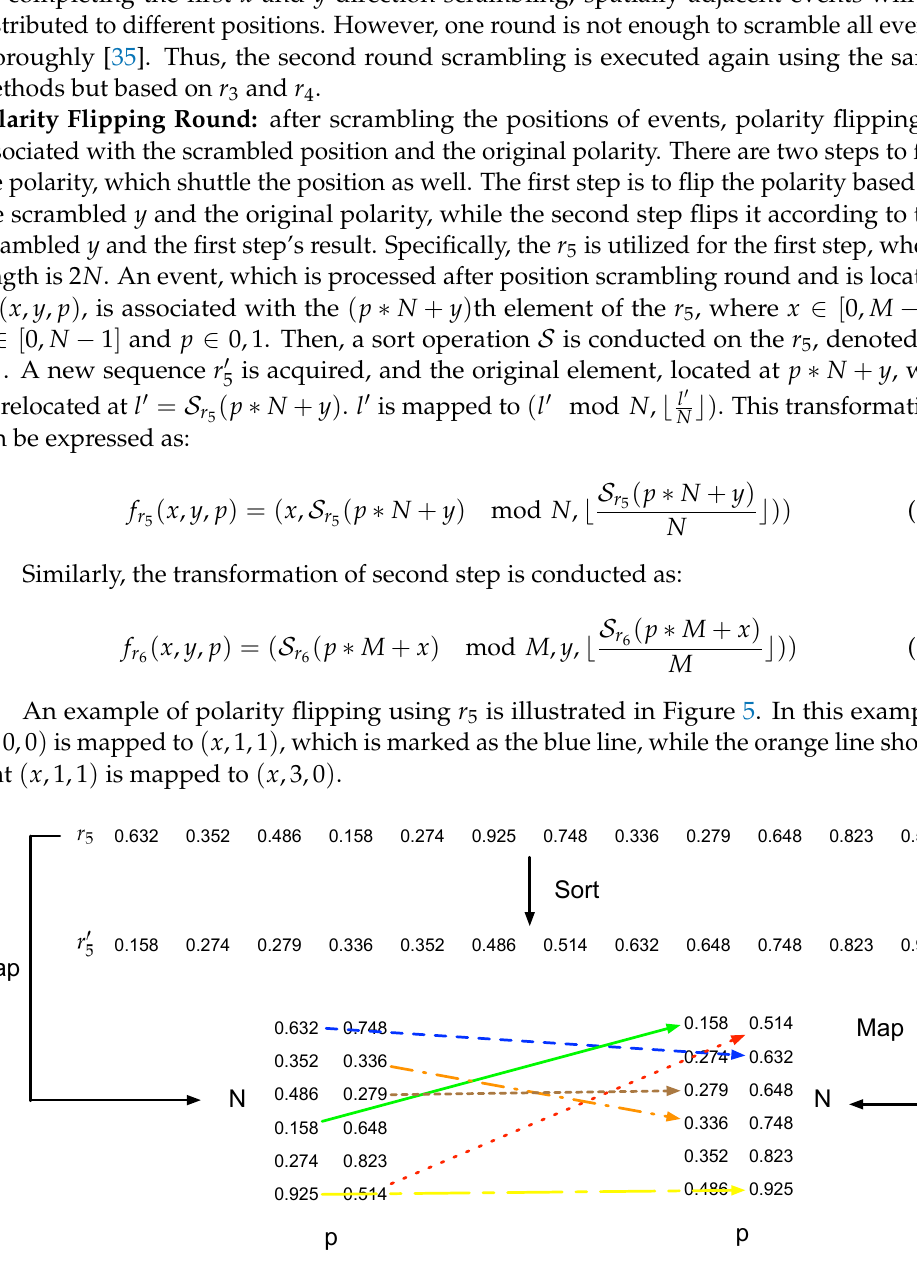
Figure 5. A polarity flipping example using r 5 to shuttle y and p